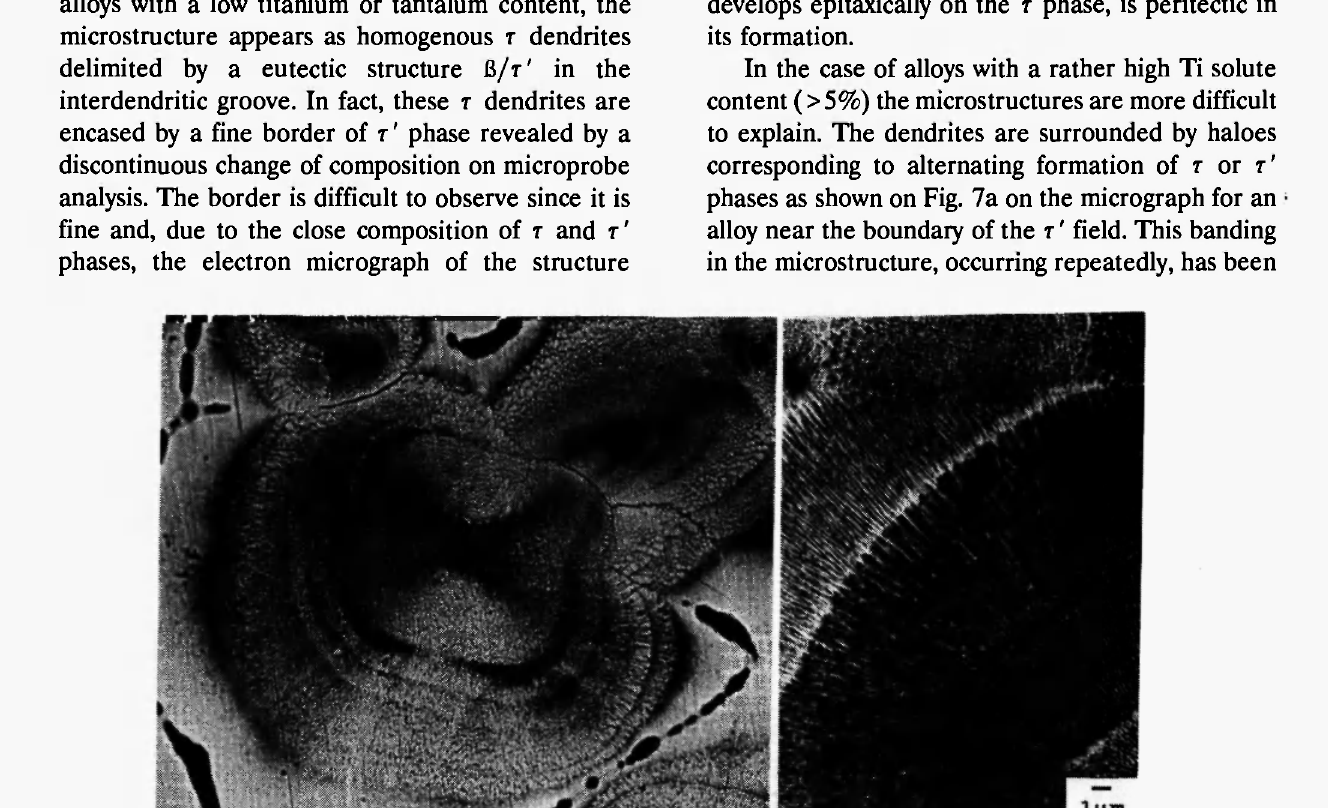
Fig. 7: Morphology of 75Ni-5Cr-11AI-9Ti alloy solidified and cooled at 300°C/h. a) optical micrograph showing the τ' dendrites surrounded by peritectic τ'/r phases; b) electron micrograph illustrating the banding at the solidification front and the eutectic-like structure.